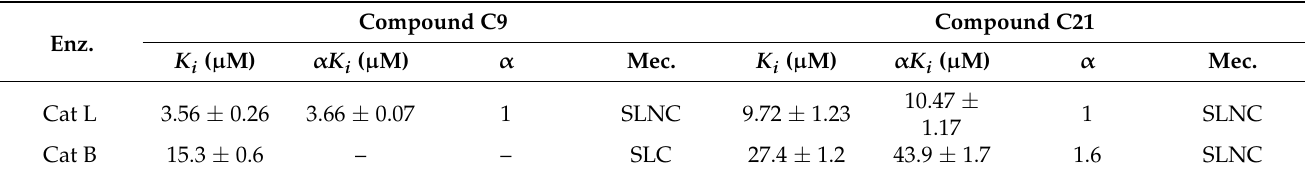
Enz = enzyme; Mec = mechanism; SLNC = simple linear non-competitive; SLC = simple linear competitive. α factor reflects the change promoted by the binding of the inhibitor to subsequent substrate binding (and vice versa).